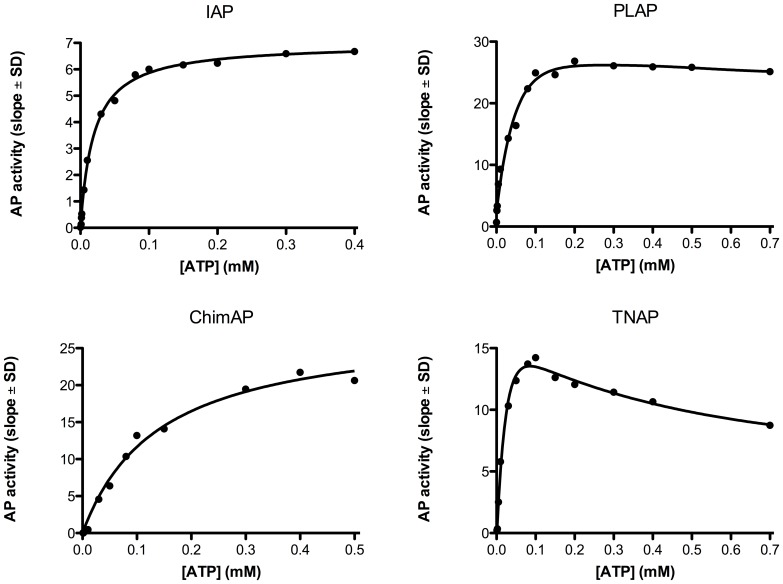
Efficiency of IAP, PLAP, ChimAP and TNAP at pHPlots are representative of three separate experiments.